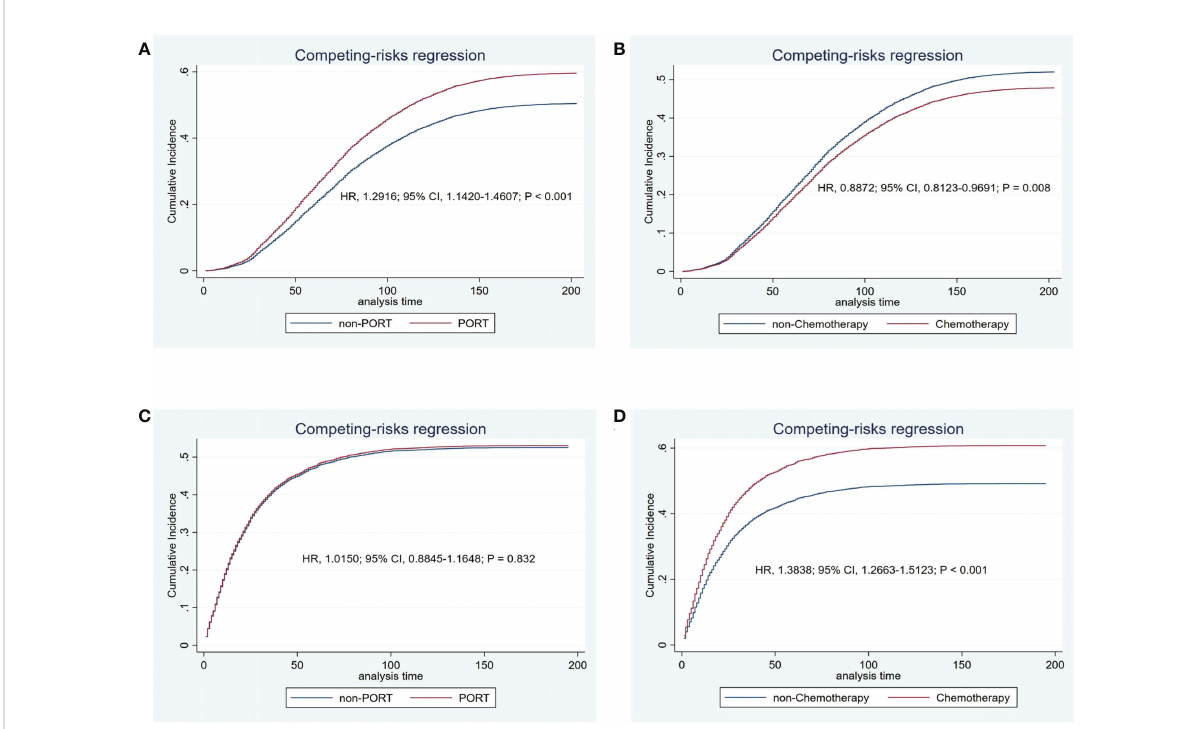
FIGURE 4 Cancer-speci fi c cumulative incidence of estimates of patients with initial lung cancer by PORT (vs. non-PORT) (A) and chemotherapy (vs. non- chemotherapy) (B) and secondary lung cancer by PORT (vs. non-PORT) (C) and chemotherapy (vs. non-chemotherapy) (D)